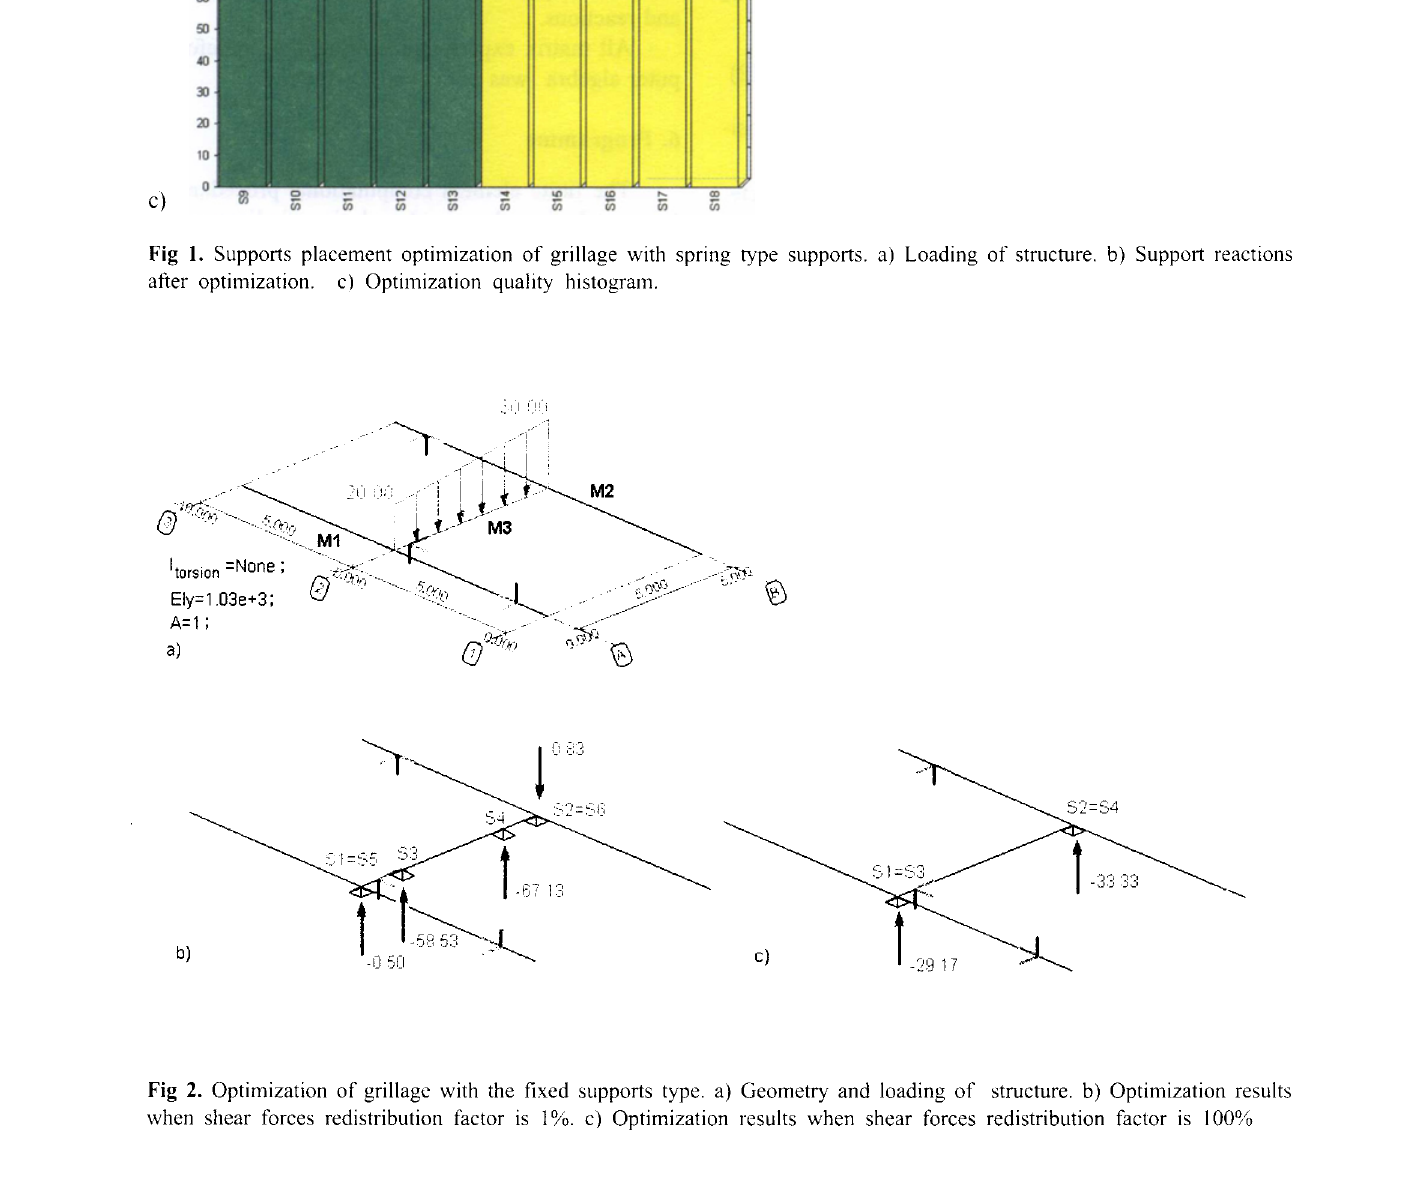
Fig 2. Optimization of grillage with the fixed supports type. a) Geometry and loading of structure. b) Optimization results when shear forces redistribution factor is I%. c) Optimization results when shear forces redistribution factor is I